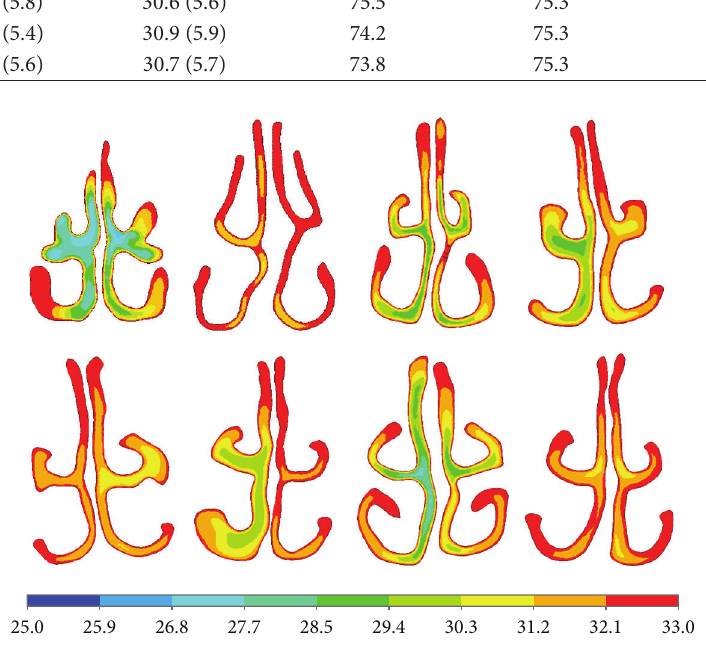
Figure 5: Airflow temperature in different size airway.